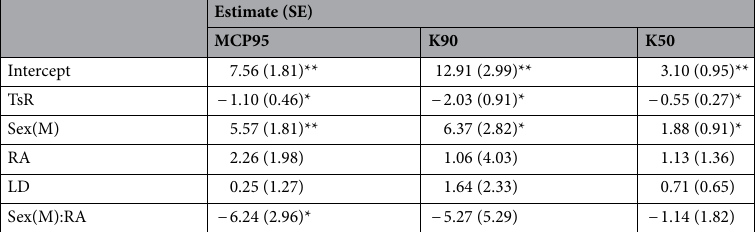
Table 4. GLMM models showing the effects of sex (S), time since release (TsR), rabbit abundance (RA), lynx density (LD) and the interaction between S and RA, on territory size (MCP95 and K90) and core area size (K50) using the global model. The effect of sex is given relative to females territory. Significance levels (**p < 0.01, *p <